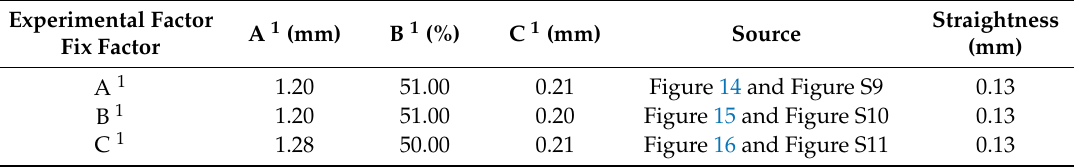
Table 4. Value of Experimental Factor for Straightness X1.